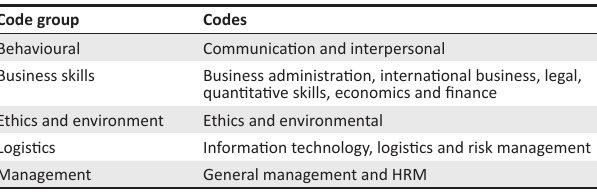
TABLE 10: Code book. Code